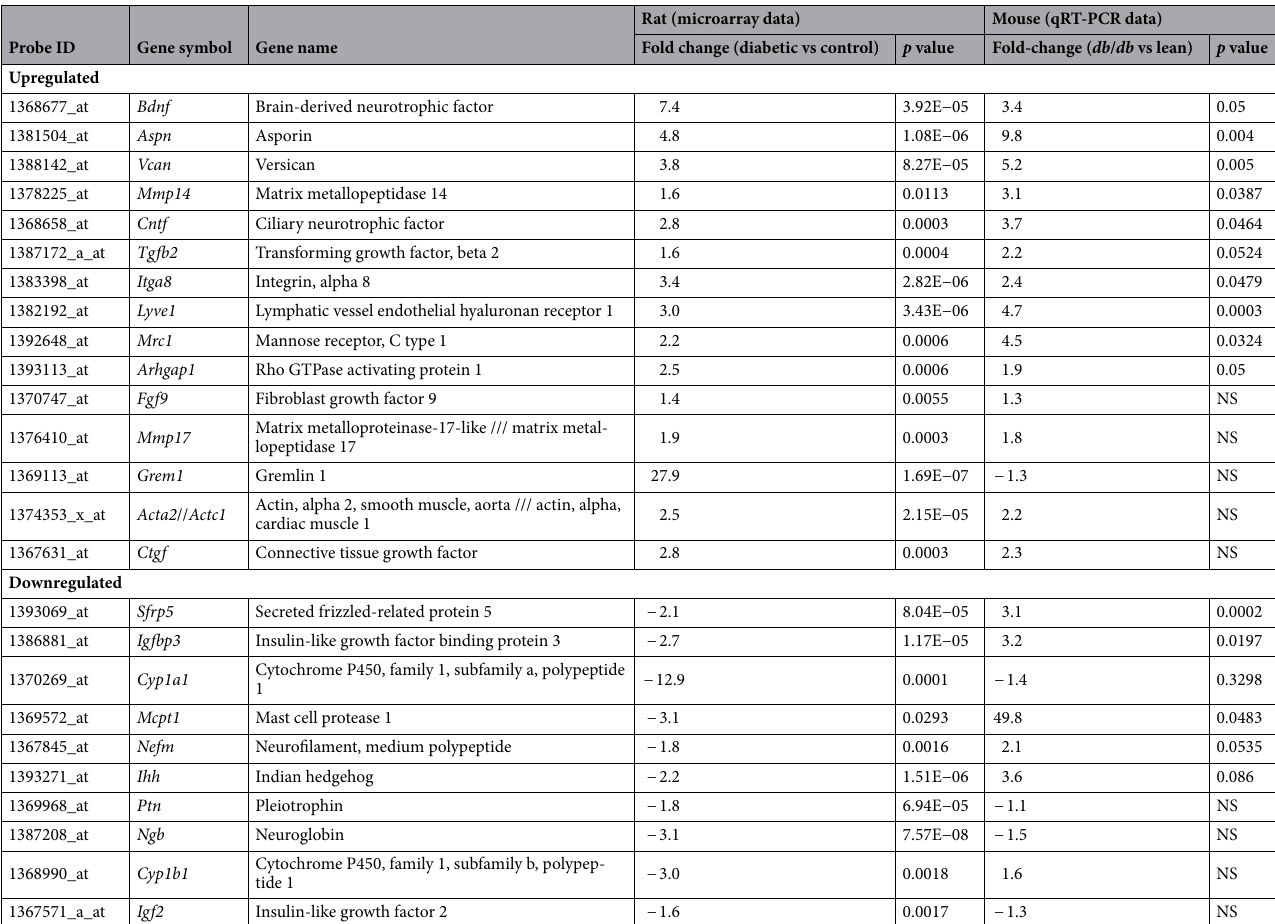
Table 2. Transcriptional changes in the db / db mouse urinary bladder. A comparison of microarray results with qRT-PCR of selected transcripts in the urinary bladder of db / db mice compared to age-matched lean controls (16 weeks) reveals some similarities and differences between the two